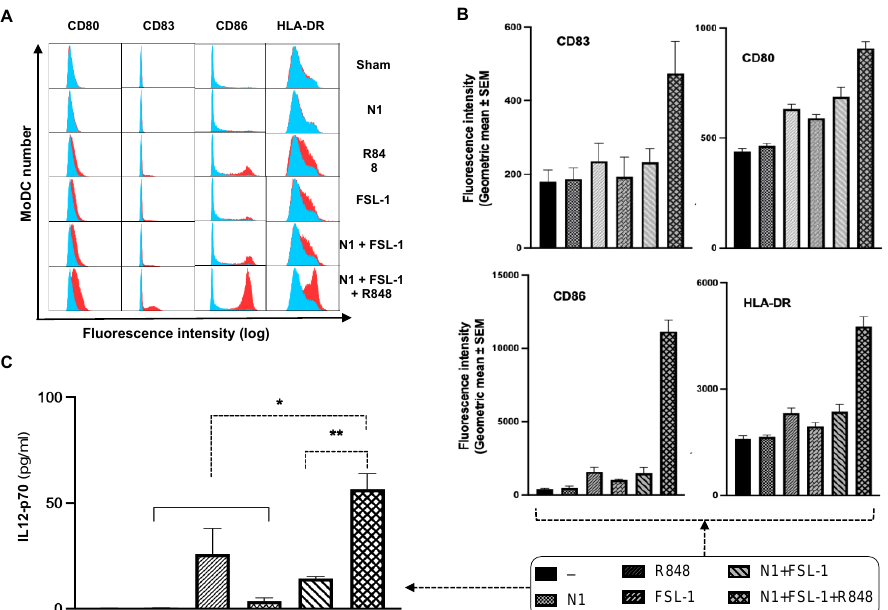
Figure 1. Synergistic activation of human monocytes-derived dendritic cells by HMGN1, R848, and FSL-1. ( A ) Overlay histograms (blue = sham/untreated DC, red = treated DCs) showing the cooperatively enhanced upregulation of DC surface costimulatory molecules (CD80, CD83, CD86) and MHC (HLA-DR) in response to combinational treatment with HMGN1+FSL-1+R848 (data of one experiment representative of three independent experiments). ( B ) Average mean fluorescence intensity of DC surface CD80, CD83, CD86, and HLA-DR (mean + SEM, N = 3). ( C ) Synergistic promotion of MoDC IL-12p70 production (* p < 0.05 and ** p < 0.001). Quantification of Multiplex ELISA measurements by Meso Scale Discovery (in pg/mL, mean + SEM, N = 3) of DC supernatant in response to combinational treatment.